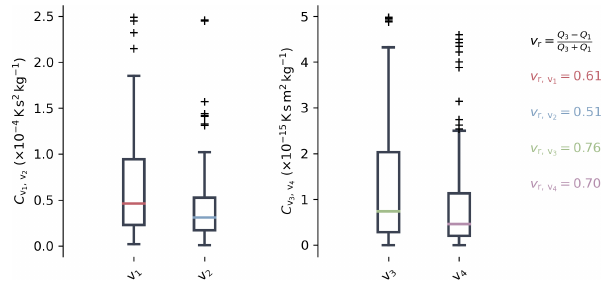
Figure 6. Box plots showing the distribution of the best factors, C v to C v , for the four variants of the constitutive equation describing 4 grain boundary sliding (Eqs. 2 to 5) derived using the optimization scheme described in Sect. 2.2. The quartile coefficient of disper- sion v r of each variant is shown on the right in the corresponding color. The quartile coefficient of dispersion was calculated using the first ( Q 1 ) and third ( Q 3 ) quartile values of the datasets, which are shown in black and represent a robust relative measure of disper-